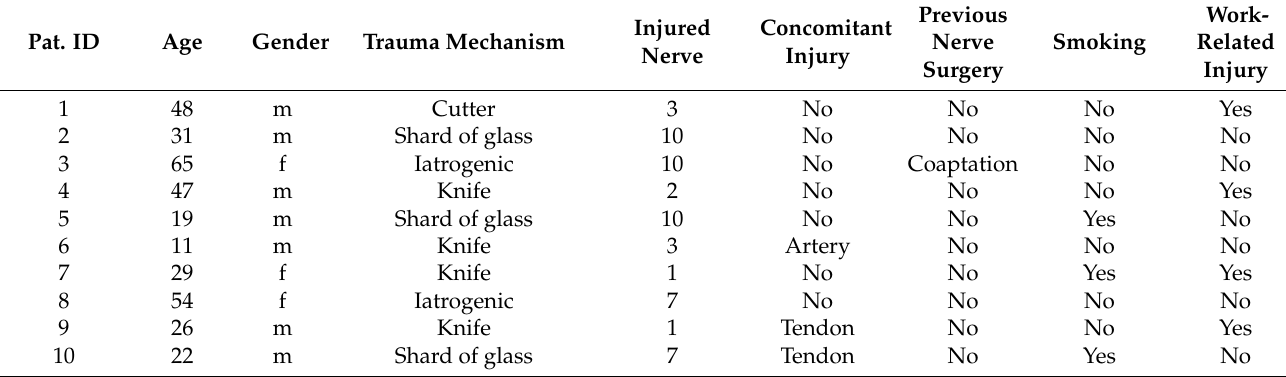
Table 1. Demographic patient characteristics.